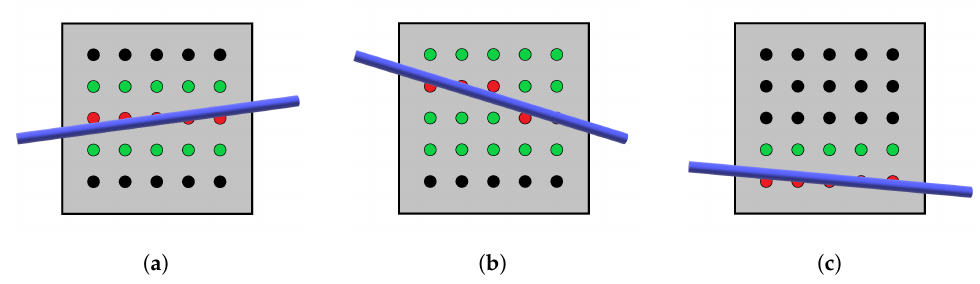
Figure 3. Examples for rows selection: wire on one row ( a ); wire on two rows ( b ); wire on the edge ( c